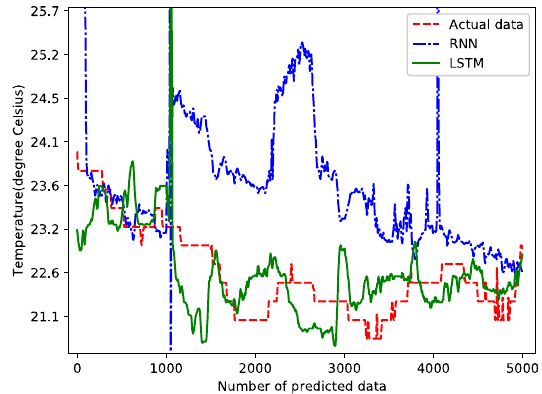
Figure 18. Comparison of the long ‐ term prediction effect for pH.